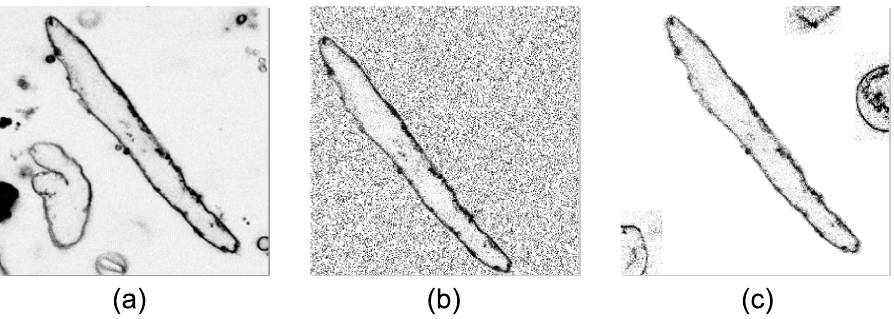
Fig 3. Augmentation of source images by manually modified images. A cut-out of a cardiomyocyte was created from the original source image (a). Placing the cardiomyocyte on a noisy and neutral background, two manually modified source images (b) and (c) were created, respectively. The second manually modified image (c) was enhanced by cell fragments and out-of-focus cardiomyocytes. Note that the displayed images were inverted and enhanced using gamma correction for better representation in the